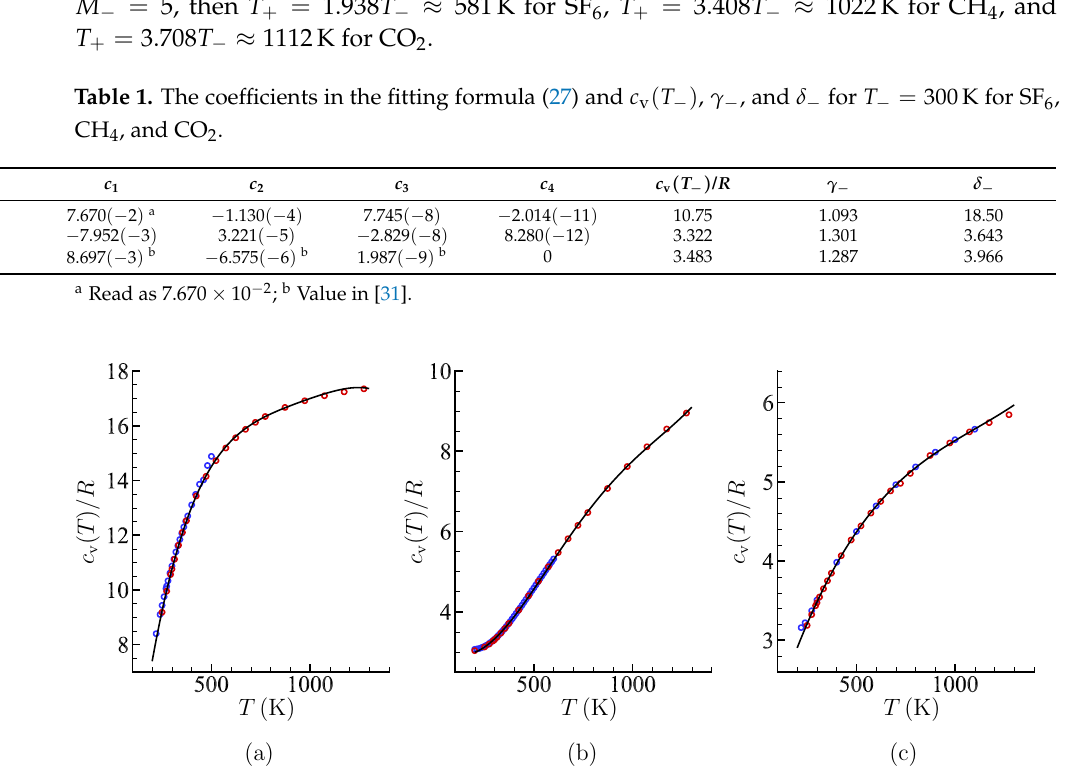
Figure 1. c v ( T ) / R vs. T . ( a ) SF 6 , ( b ) CH 4 , and ( c ) CO 2 . The solid line indicates the fitting Formula (27) with the data in Table 1, the red circles represent the data from [60], and the blue circles denote those from